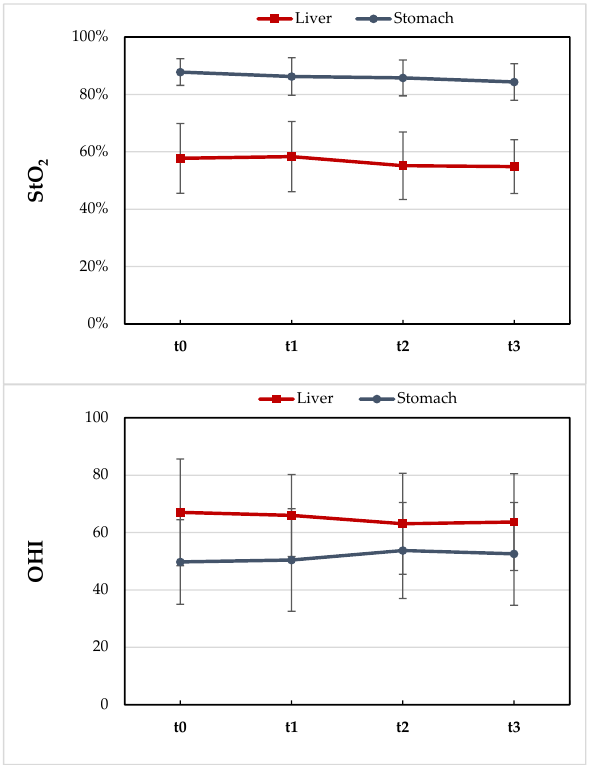
Figure 5. Distribution of tissue oxygenation (StO 2 in %) and hemoglobin content (OHI) (0–100) in all patients before and after the GDA-clamping test.